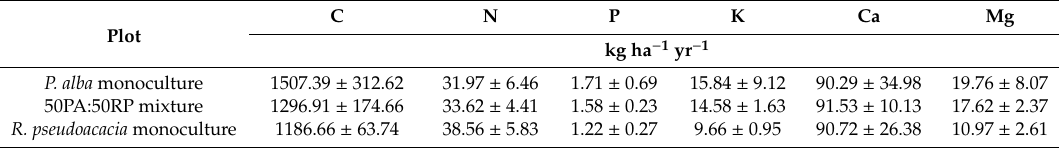
Table 5. Carbon, Nitrogen, Phosphorus, Potassium, Calcium and Magnesium total annual weighted average contributions in leaf litter for P. alba and R. pseudoacacia monocultures, and 50PA:50RP mixture